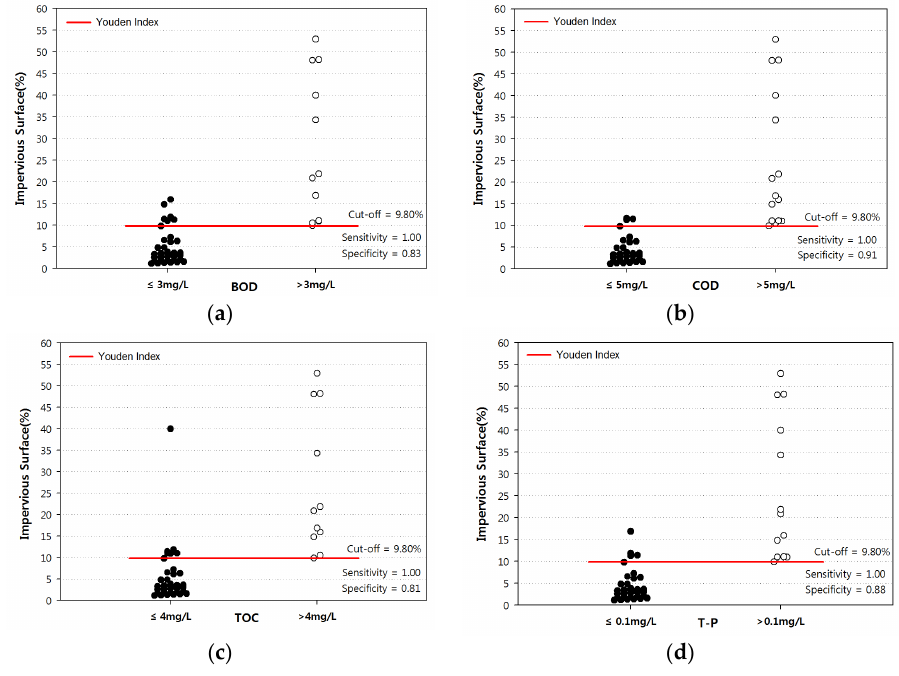
Figure 4 . The cut-off values for ( a ) BOD; ( b ) COD; ( c ) TOC; and ( d ) T-P.